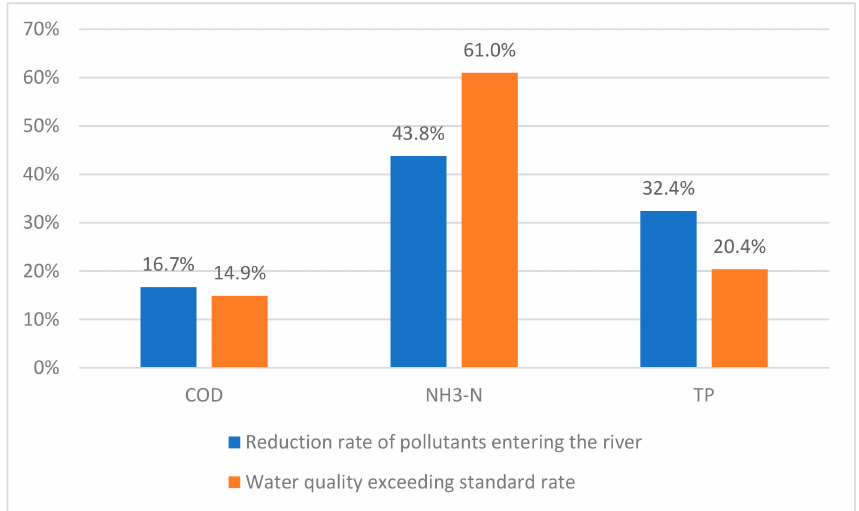
Figure 4. Comparison of calculated inflow rate reduction rate and water quality over-standard rate.